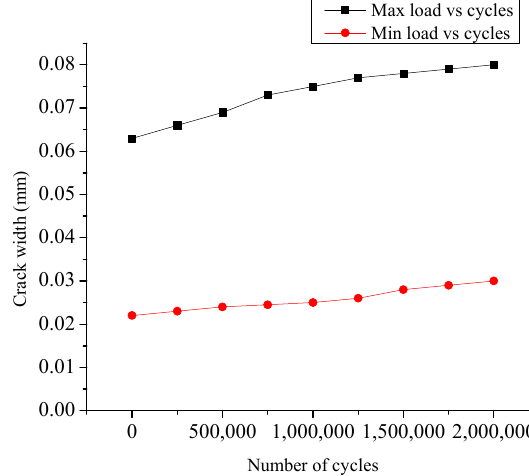
Figure 16. Crack width versus number of cycles.